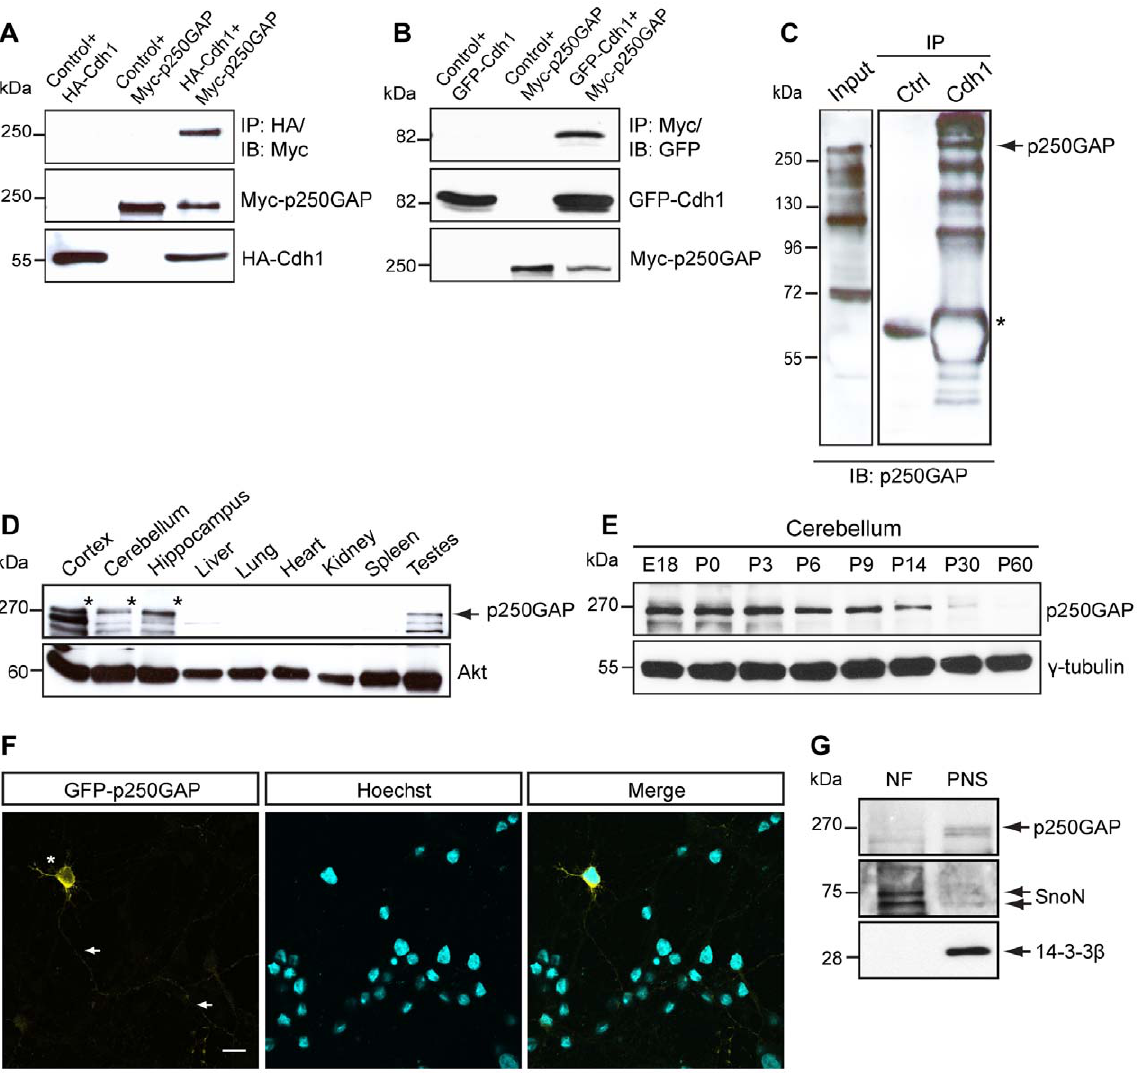
Figure 1. Brain-dominant p250GAP associates with Cdh1. A. 293T cells transfected with control vector pcDNA3 and HA-Cdh1, or control pCMV5 vector and Myc-p250GAP, or both HA-Cdh1 and Myc-p250GAP plasmids, were lysed and lysates subjected to immunoprecipitation with the HA antibody and immunoblotting with the Myc antibody. B. Lysates of 293T cells transfected with control vector pcDNA3 and GFP-Cdh1, or GFP and Myc-p250GAP plasmid, or plasmids encoding GFP-Cdh1 and Myc-p250GAP were subjected to immunoprecipitation with the Myc antibody followed by immunoblotting with the GFP antibody. C. Total brain lysate from P9 mouse was subjected to immunoprecipitation with control serum or Cdh1 antiserum followed by immunoblotting with p250GAP antiserum. Arrow indicates p250GAP and asterisk IgG H . D. Lysates of indicated tissues were collected from wild type P60 mouse and subjected to immunoblotting using the p250GAP antibody. Akt served as loading control. Asterisks indicate p250GAP. E. Cerebella were collected from wild type rats at the indicated days and the lysates were subjected to immunoblotting using the p250GAP antibody. c -tubulin served as loading control. E=embryonic, P=postnatal. F. Granule neurons were transfected at DIV 1 with GFP-p250GAP and at DIV 3 subjected to immunocytochemistry with the GFP antibody and the nuclear dye bisbenzimide Hoechst 33258. Arrows and asterisk indicate axons and soma, respectively. Scale bar equals 10 m m. G. Cerebellar granule neurons were subjected to subcellular fractionation at DIV 3. Nuclear (NF) and postnuclear supernatant (PNS) fractions were immunoblotted using p250GAP, SnoN and 14-3-3 b antibodies. SnoN and 14-3-3 b served as controls for NF and PNS, respectively.